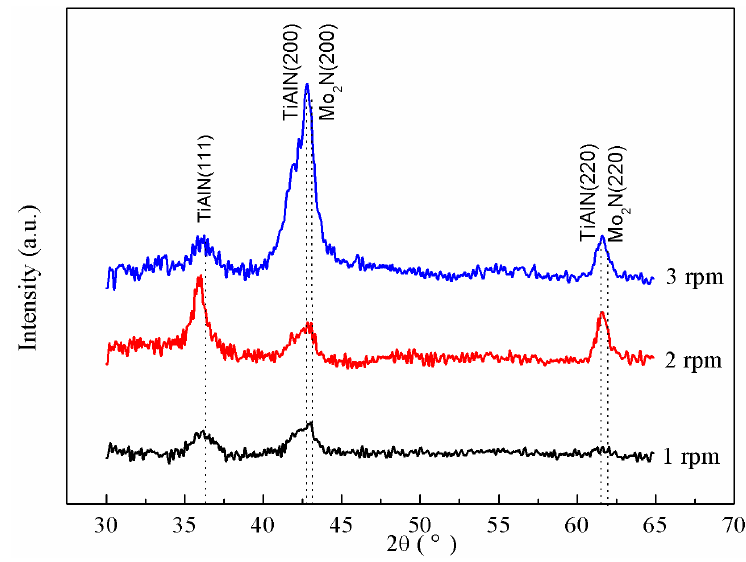
Figure 4. XRD patterns of Mo-Ti-Al-N composite coatings fabricated at 1, 2, and 3 rpm.